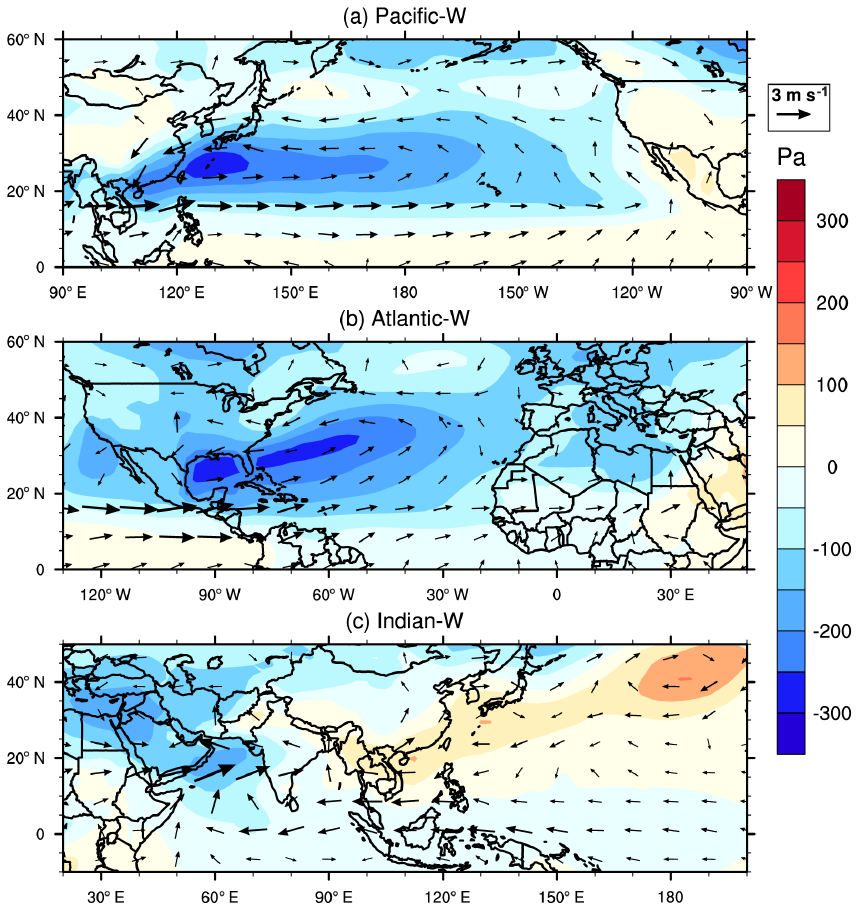
Figure 5. Changes in the surface pressure (color contours, Pa) and 850hPa wind (arrows,ms − 1 ) for (a) Pacific-W, (b) Atlantic-W, and (c) Indian-W relative to the CTRL in the boreal